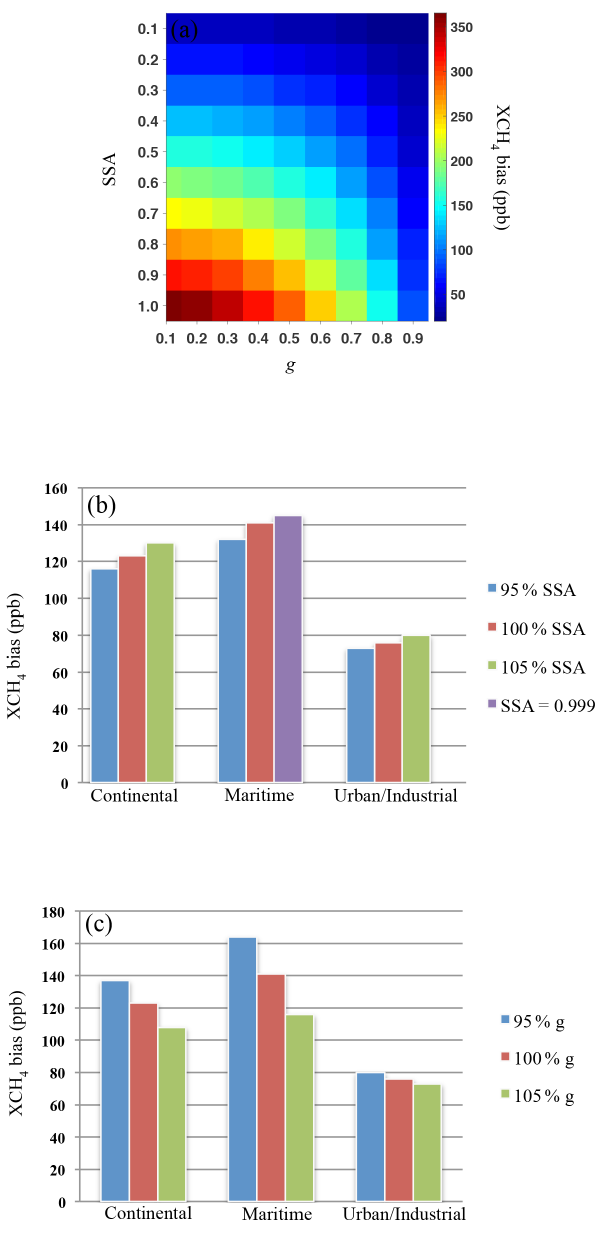
Figure 7. (a) CH 4 retrieval biases for different values of g and SSA. Surface albedo, AOD = 0 . 3, XCH 4 = 1 . 0 × 1 . 822ppm. (b) CH 4 re- trieval biases for a ± 5% change in SSA for the three aerosol mix- ture models. (c) Same as (b) , but for a ± 5% change in g .